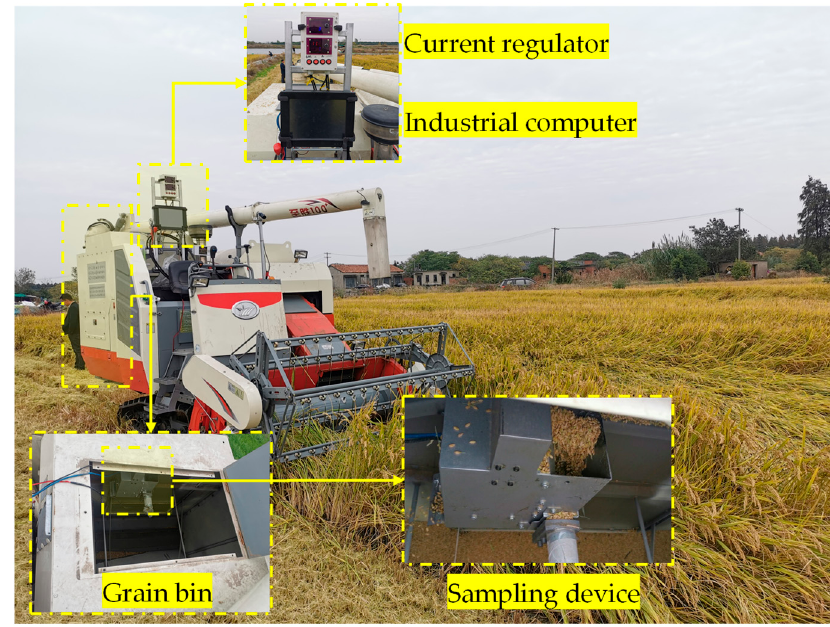
Figure 1. Impurity-detection system for tracked rice combine harvester.